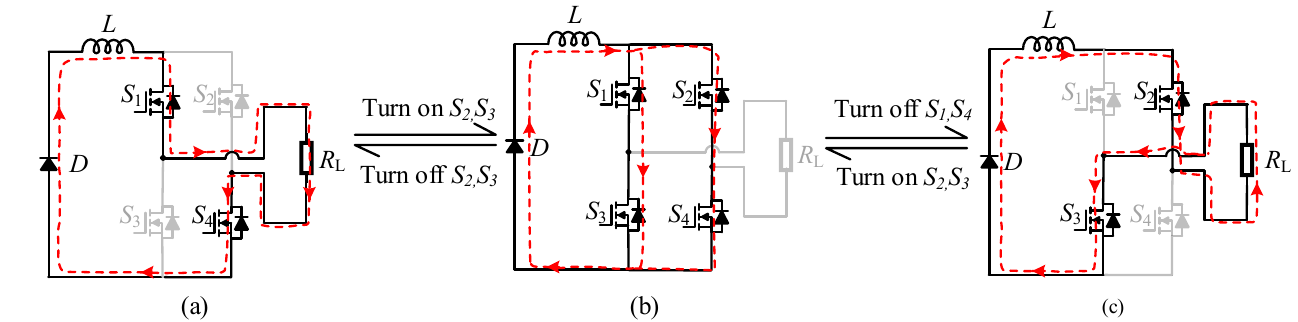
(b) Analysis of Communication between the P- and N-Modes during the Discharging State During the discharging state, S 1 / S 4 and S 2 / S 3 turned on and off when the working